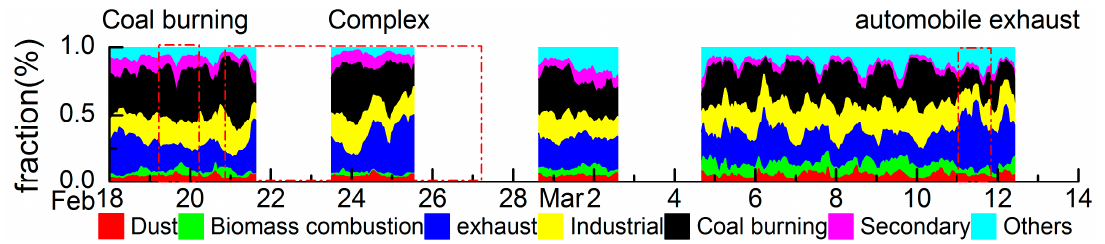
Figure 2. Time series PM 10 sources during the study periods in 2014. Hatched frames refer to the identified haze pollution episodes.